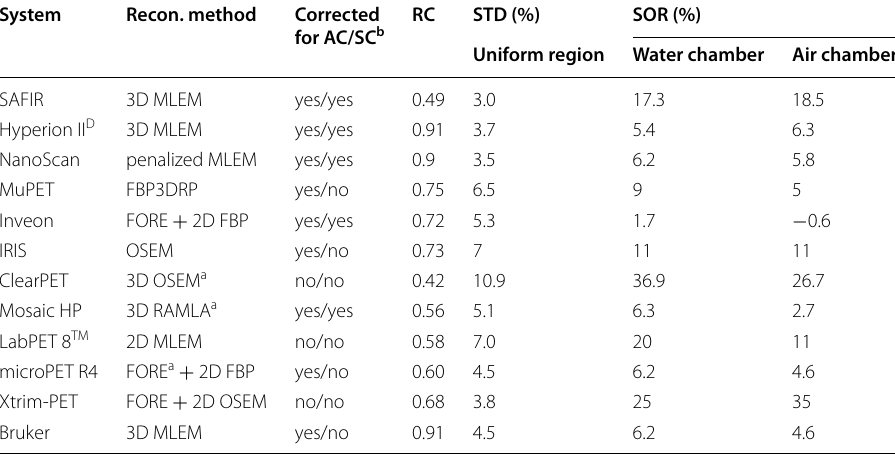
a FORE Fourier Rebinning; RAMLA = Maximization b AC Attenuation Correction; SC =